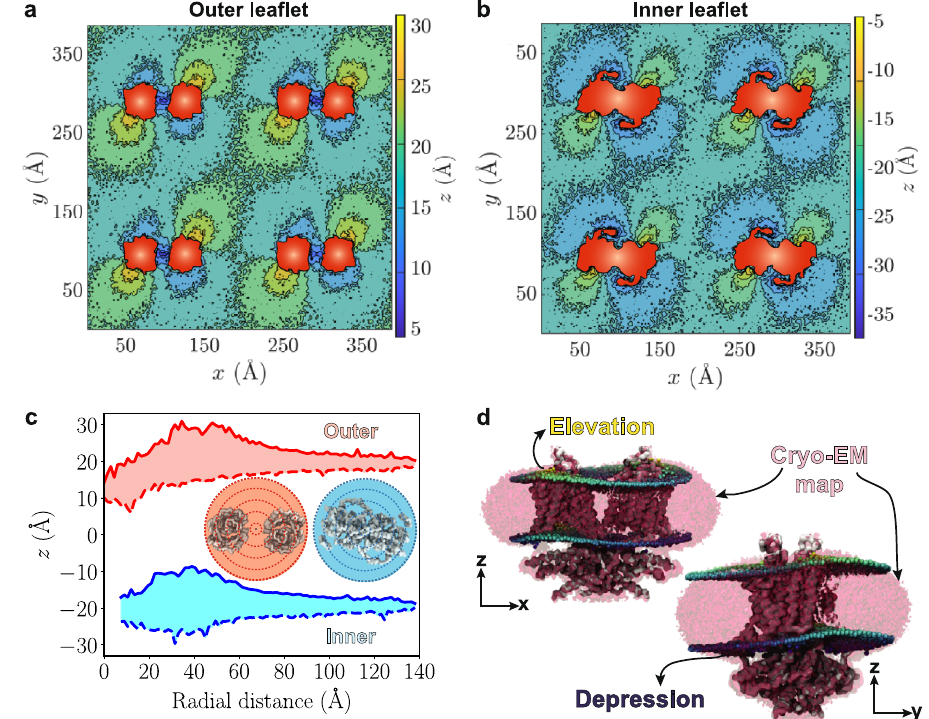
Fig. 2 | Prestin-induced, anisotropic membrane deformation. a and b 2D his- tograms of the z positions of lipid headgroups for outer and inner lea fl ets. Both lea fl etsareviewedfromtheextracellularside.Histogramsareconstructedfromthe last5 μ sof20- μ strajectories.Thecross-sectionalareasoftheprestindimersineach lea fl et are colored in red. c Range of z values of lipid headgroups in radial sections (drawn in the inset) around the protein, red for the outer and blue for the inner lea fl et. The maximum elevation values are represented with solid and minimum values with dashed lines, whereas the range of observed z values is shown in light redandblue.Thebluecurvesdonotstartfromzero,sinceintheinnerlea fl etthere